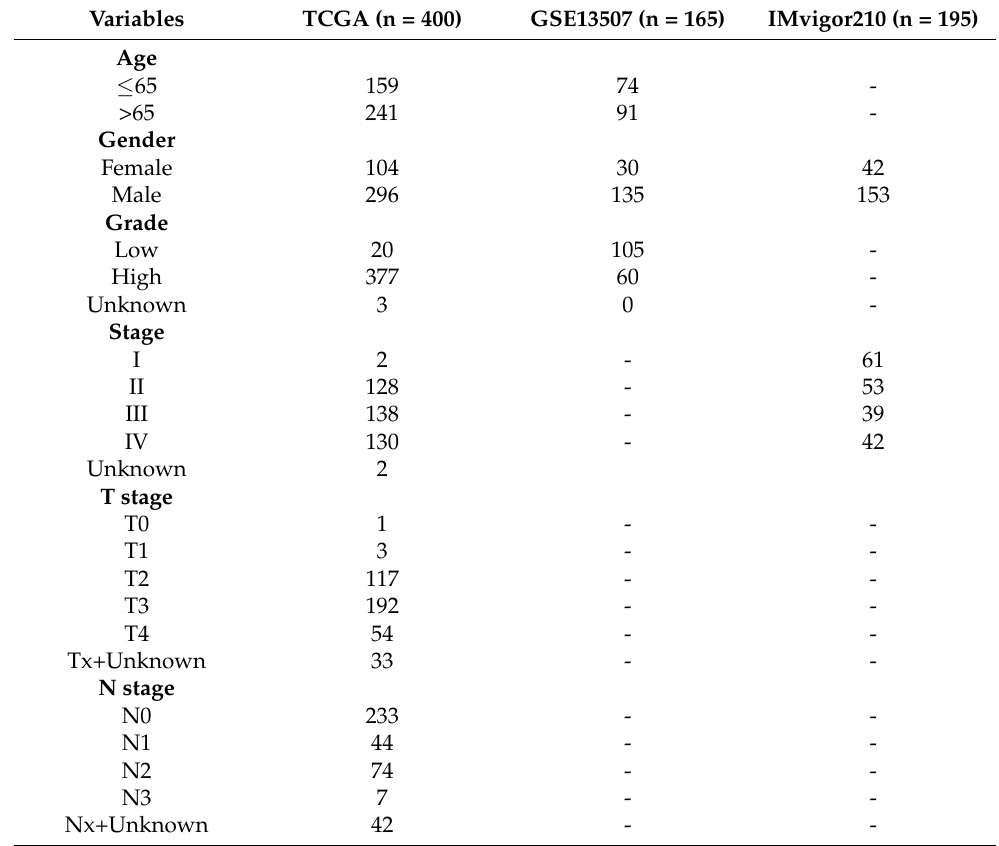
Table 1. The clinical characteristics of 760 BLCA patients enrolled in this